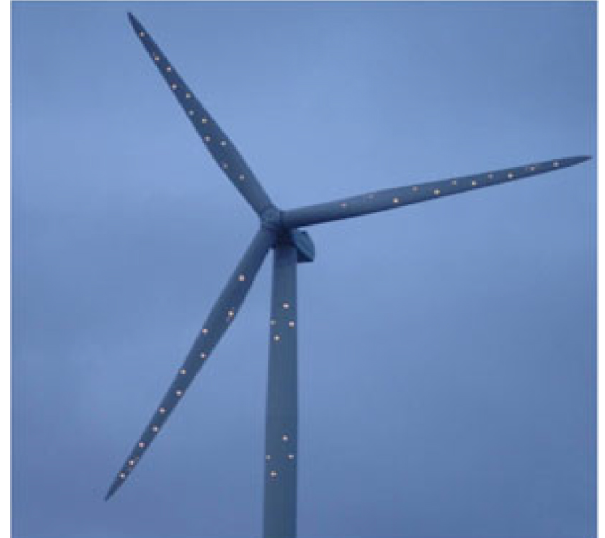
Figure 6. Example of turbine instrumentation with reflective mark- ers for photogrammetry or laser interferometry (Ozbek and Rixen,